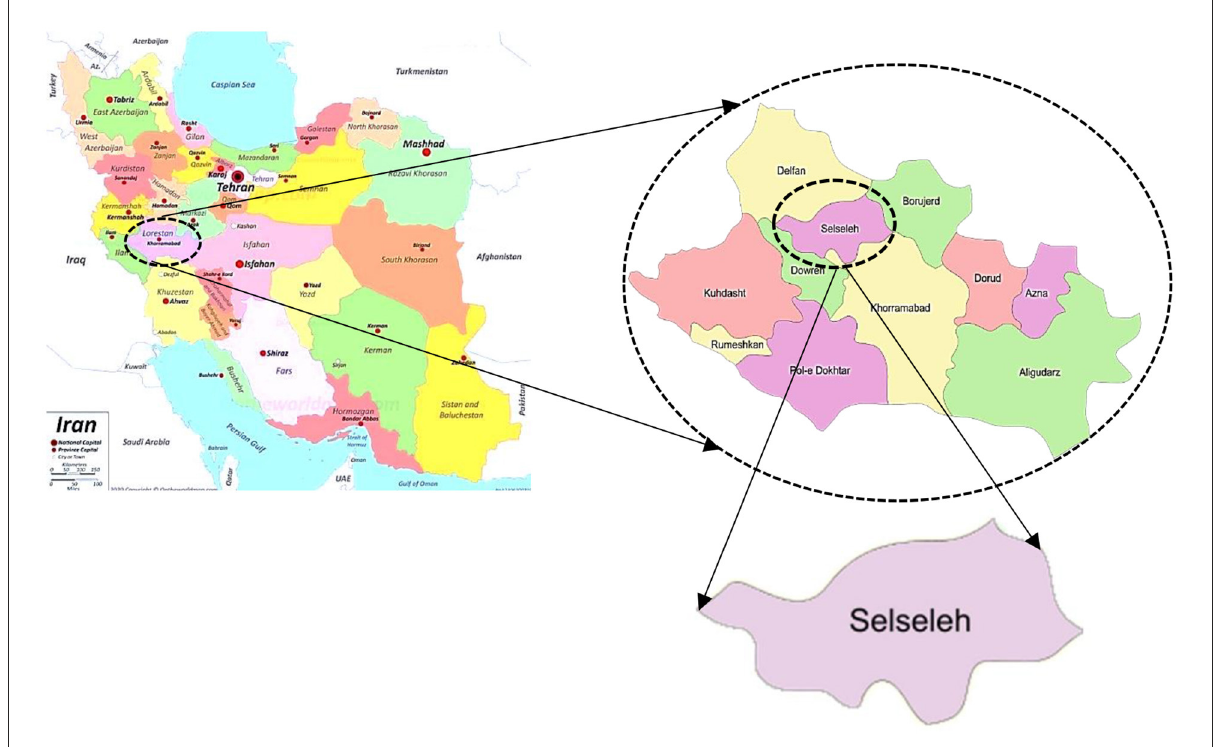
FIGURE1 The map of study location.